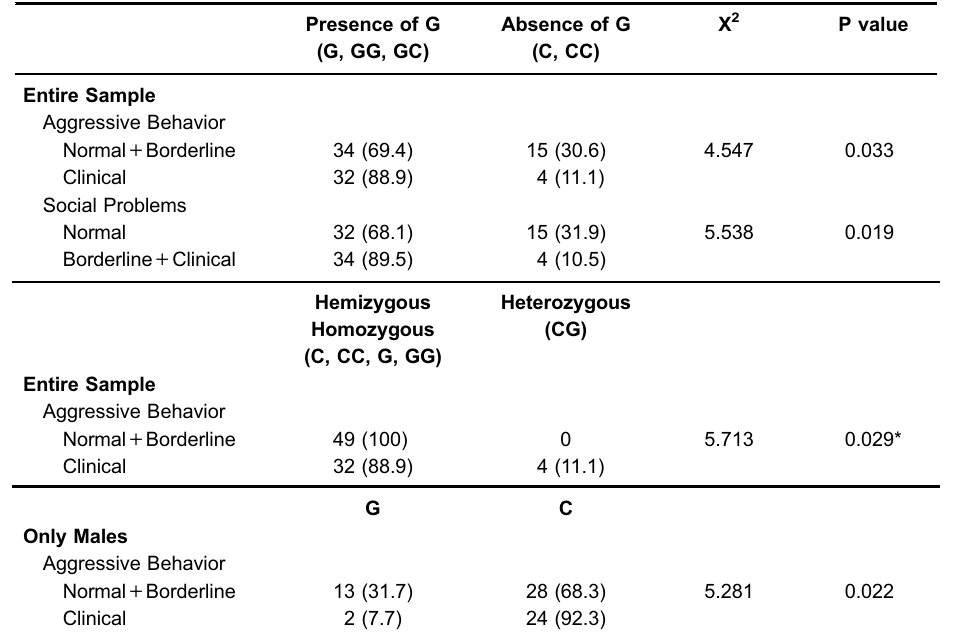
Table 2. Associations between the CBCL/6-18 results and SNP